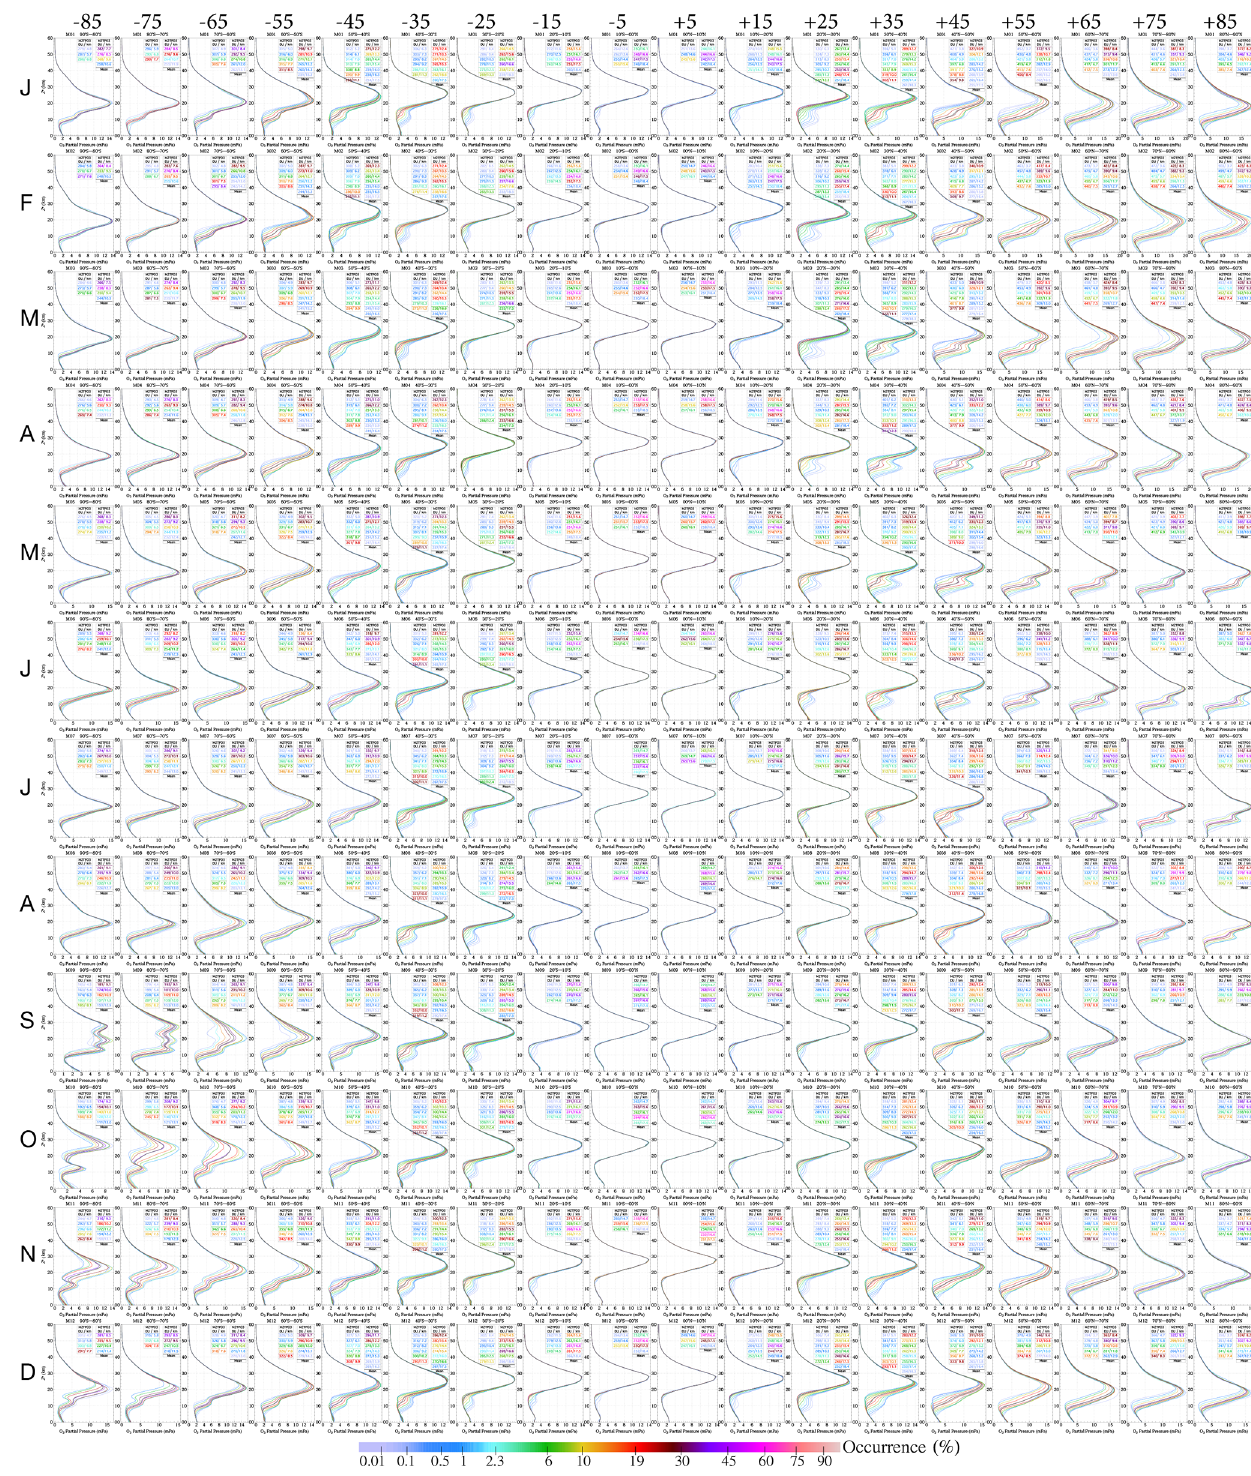
Figure A1. The daytime M2TPO3 climatology contains 2154 O 3 profiles that are distributed among the 12 × 18 month–latitude classes. The color of a solid line indicates the percentage occurrence of the profile. The line legends display the average tropopause altitudes and the average total O 3 columns. The solid gray line represents the downgraded M2TPO3 profile, i.e., the monthly zonal mean